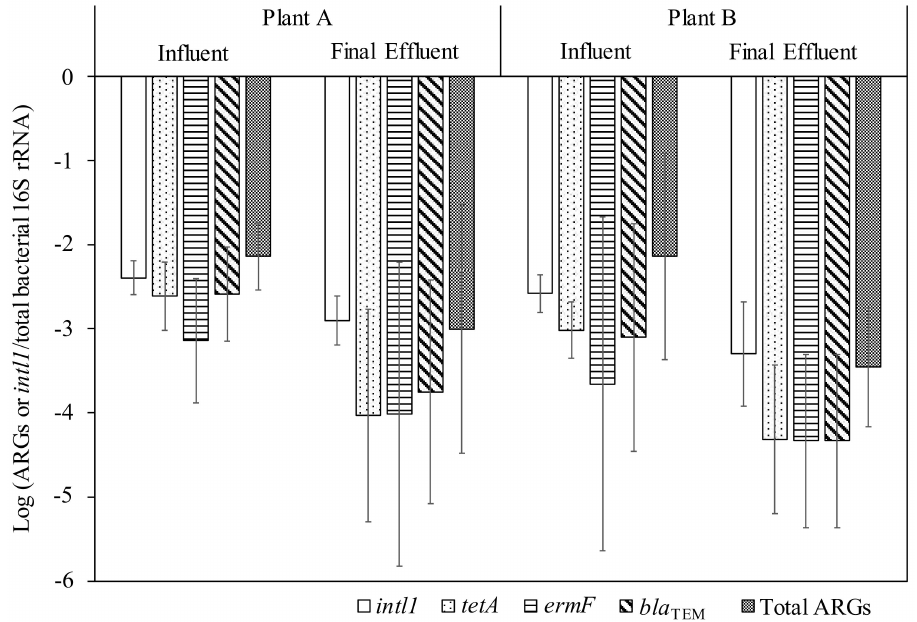
Figure 2. Concentrations of total bacteria, ARGs, and intI1 in the wastewater